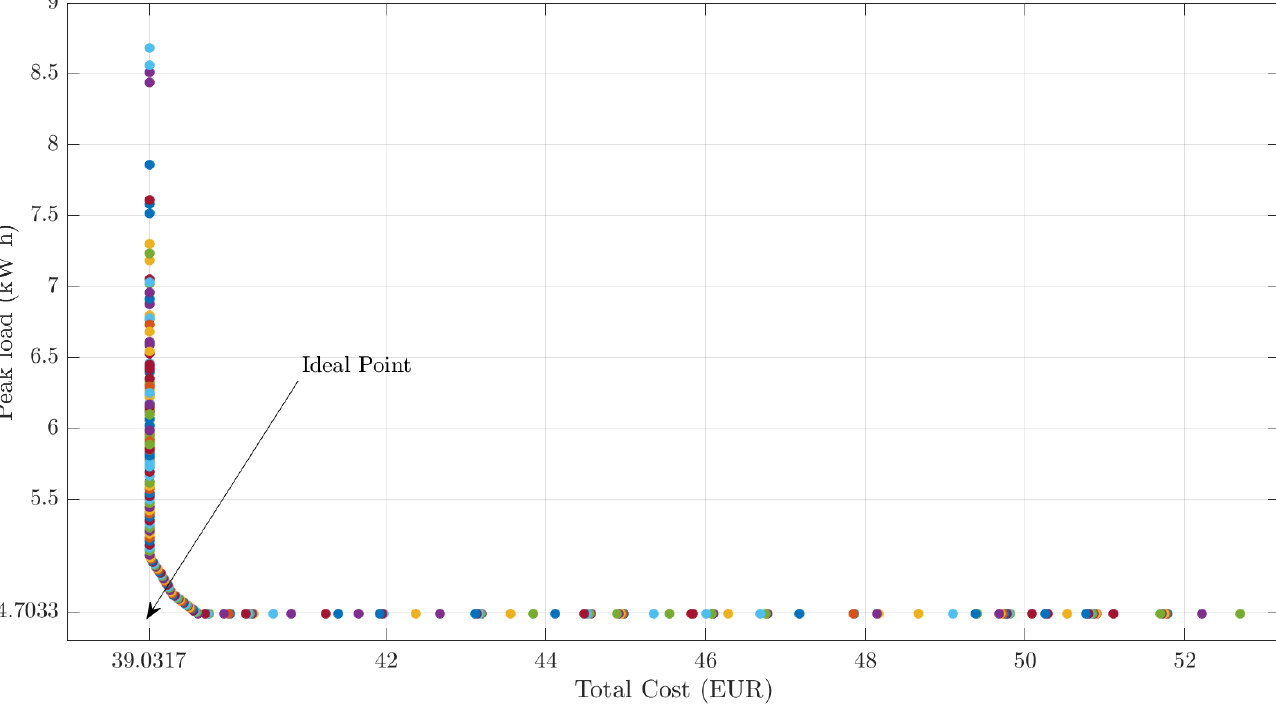
Figure 1. The obtained Pareto front for problem (7).